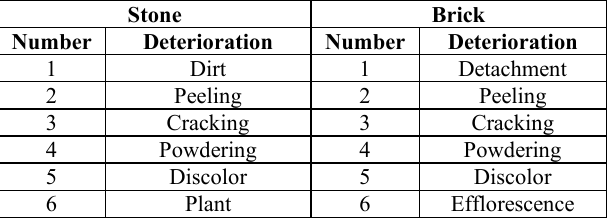
Table 1. Masonry deteriorations category in the Forbidden City.